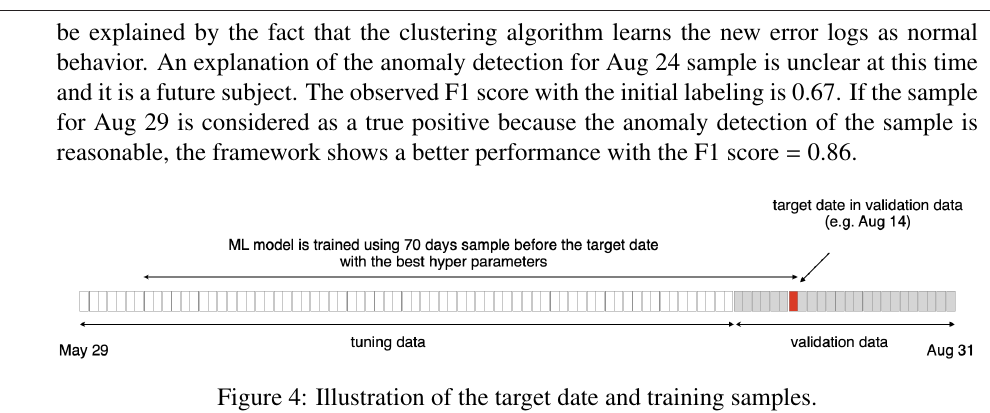
Figure 4: Illustration of the target date and training